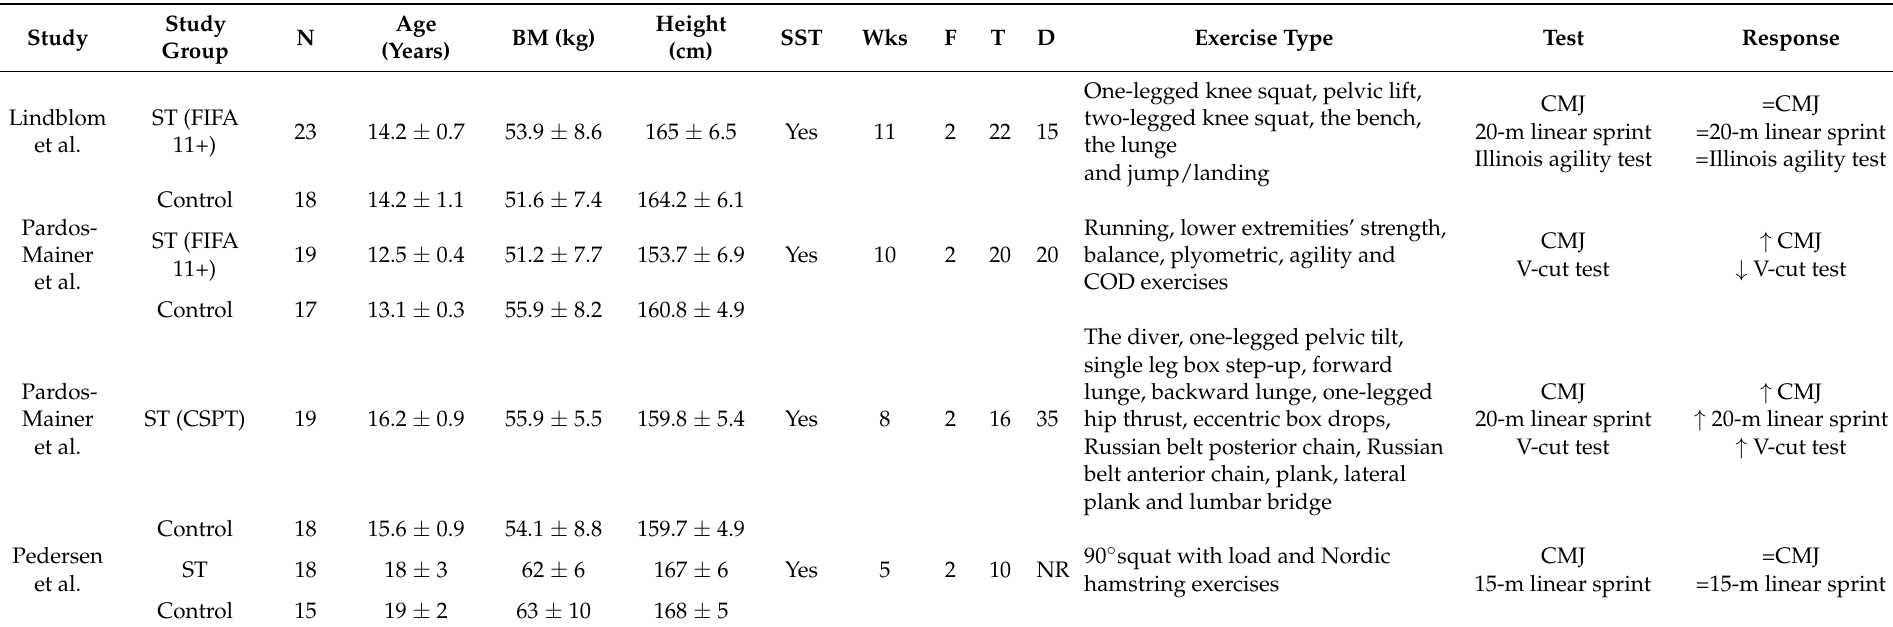
Table 2. Characteristics of study participants of strength